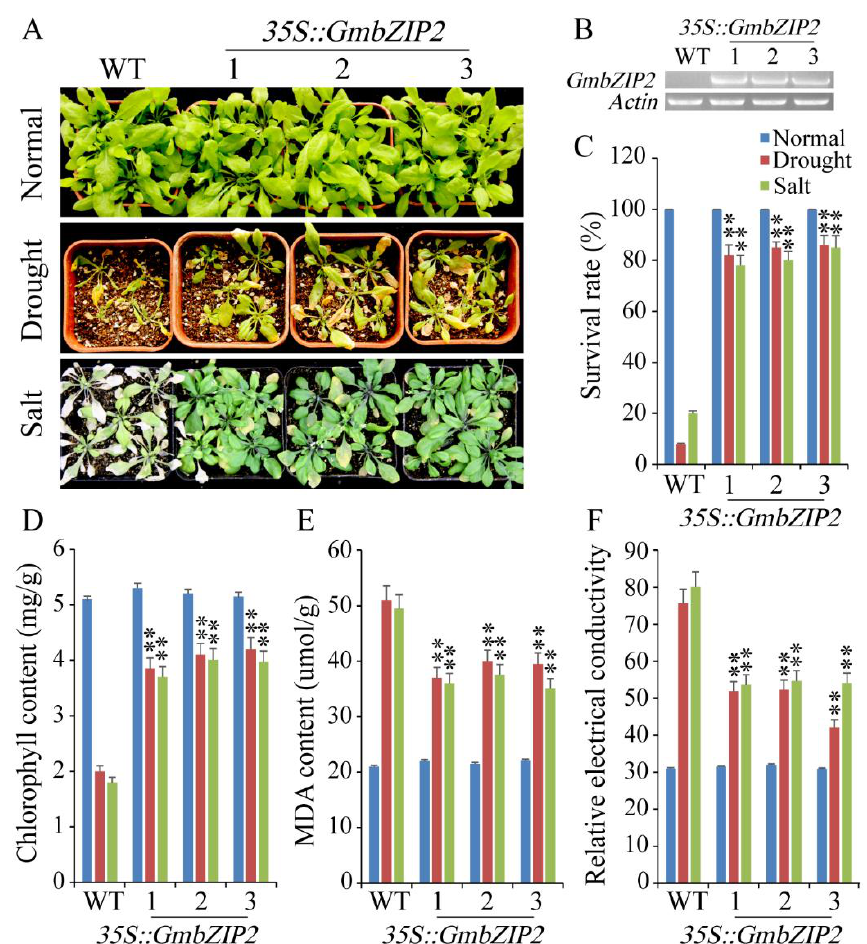
Figure 8. Phenotype identification of transgenic and WT (wild-type, WT, Col-0) seedlings under drought and salt stresses. ( A ) The growth states of transgenic and WT seedlings under drought and salt stresses. ( B ) The transcription levels of GmbZIP2 in transgenic and WT seedlings by semi-quantitative PCR. ( C – F ) The survival rates, Chlorophyll content, malondialdehyde (MDA) content and REC (relative electrical conductivity) of transgenic and WT Arabidopsis seedlings under drought and salt stresses, respectively. Vertical bars in C–F indicate ± SE of three replicates. ** indicate significant differences in comparison with the WT lines at p < 0.01.